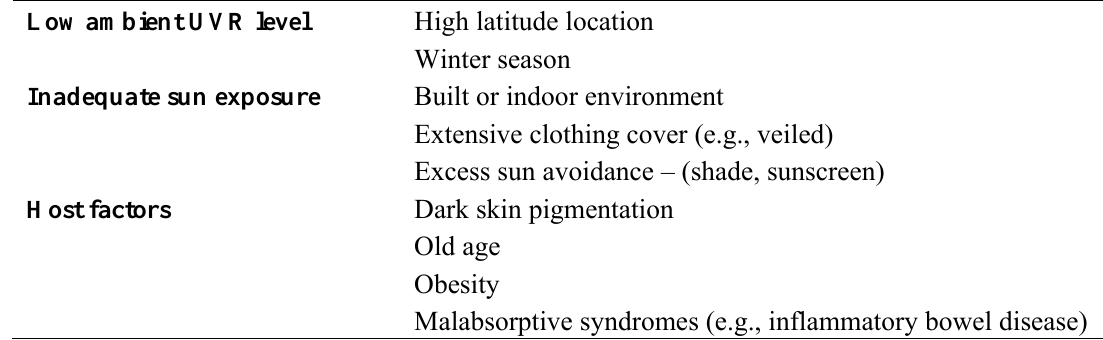
Table 1. Risk factors for vitamin D deficiency.